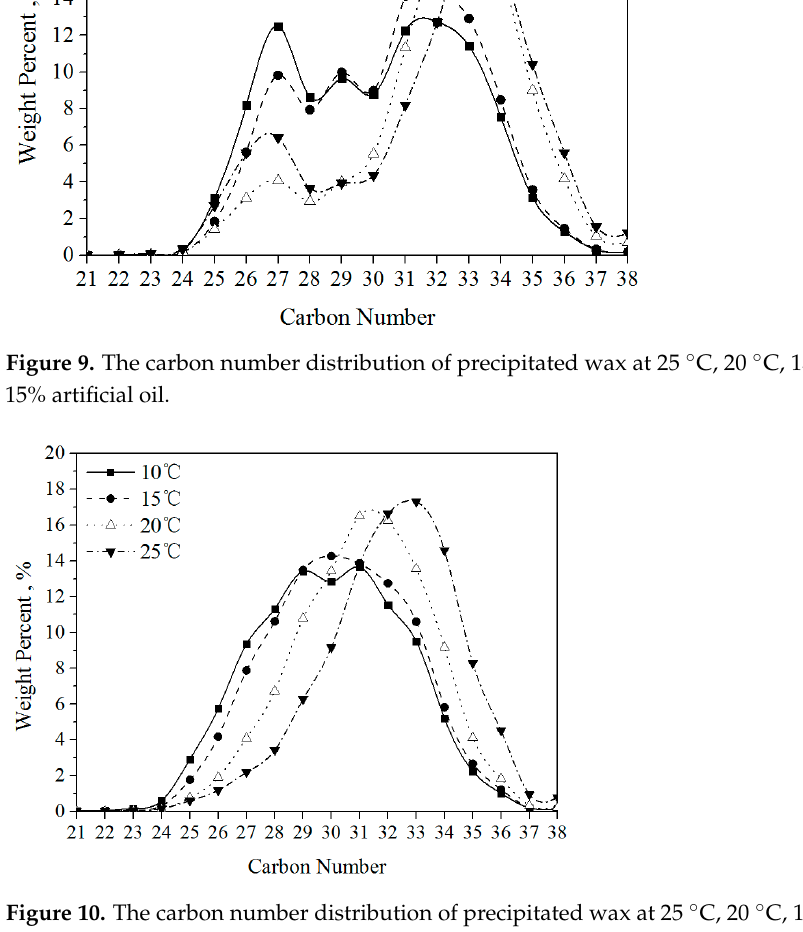
Figure 10. The carbon number distribution of precipitated wax at 25 ◦ C, 20 ◦ C, 15 ◦ C and 10 ◦ C for 20% artificial